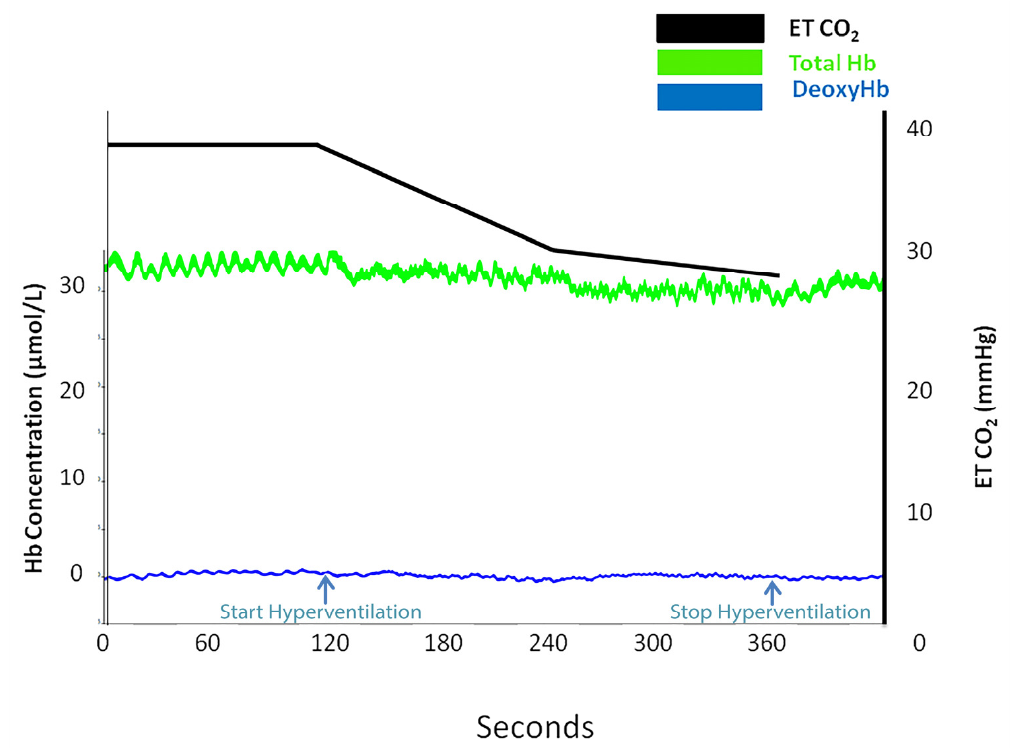
Figure 4. Total hemoglobin (tHb) trace (green), deoxyhemoglobin trace (blue), and end-tidal CO 2 trace (black) at baseline and during hyperventilation in the subject presented in Figure 2.